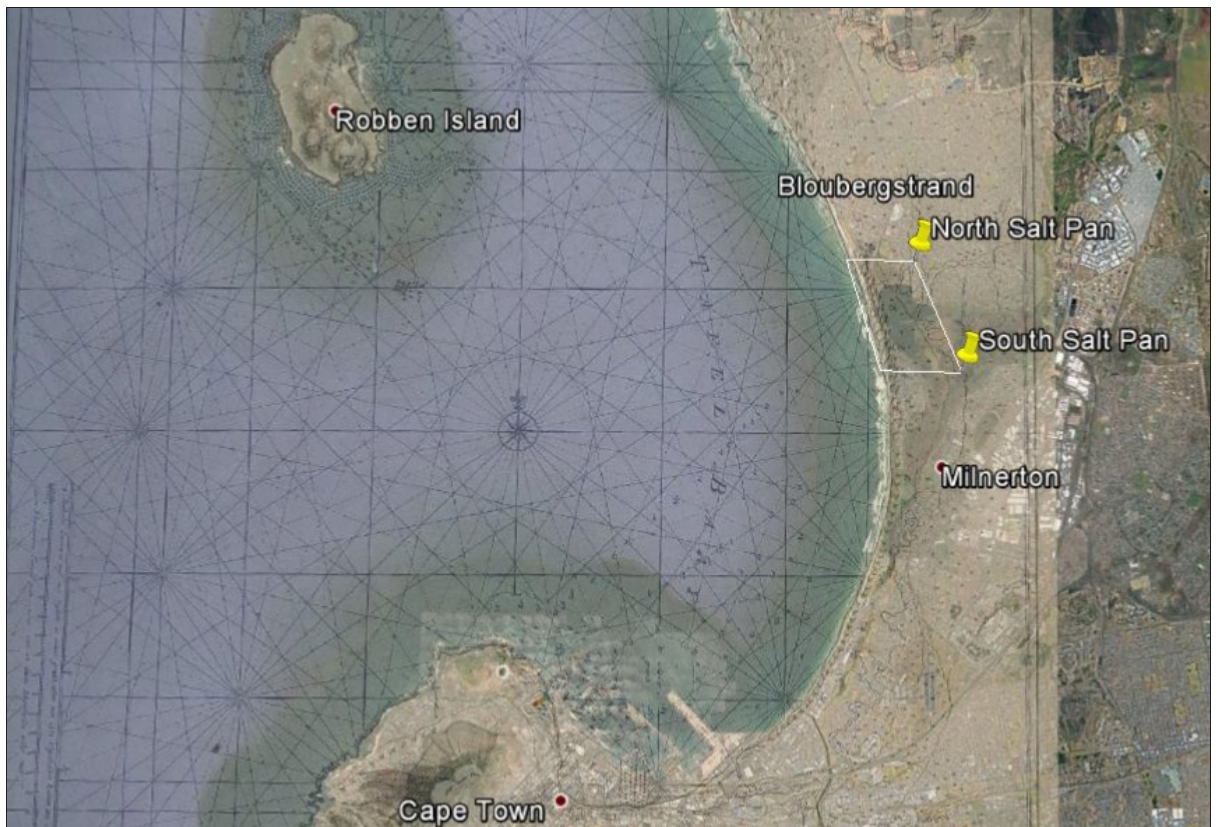
Nationaal Archief, The Hague, the Netherlands. Figure 1: Fair sheet of Table Bay, dating to 1663, with the approximate position of the Haarlem wreck marked.